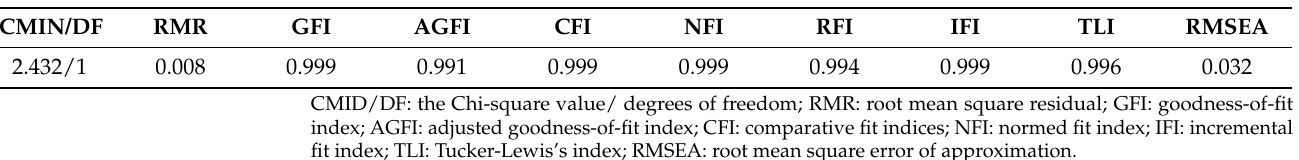
Table 2. Fitness Model Summary (N = 1405).